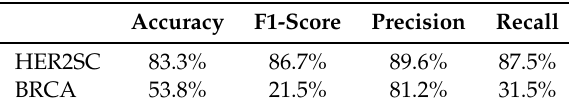
Table 2. H&E HER2 status classification results of the proposed method on the HER2SC and BRCA test